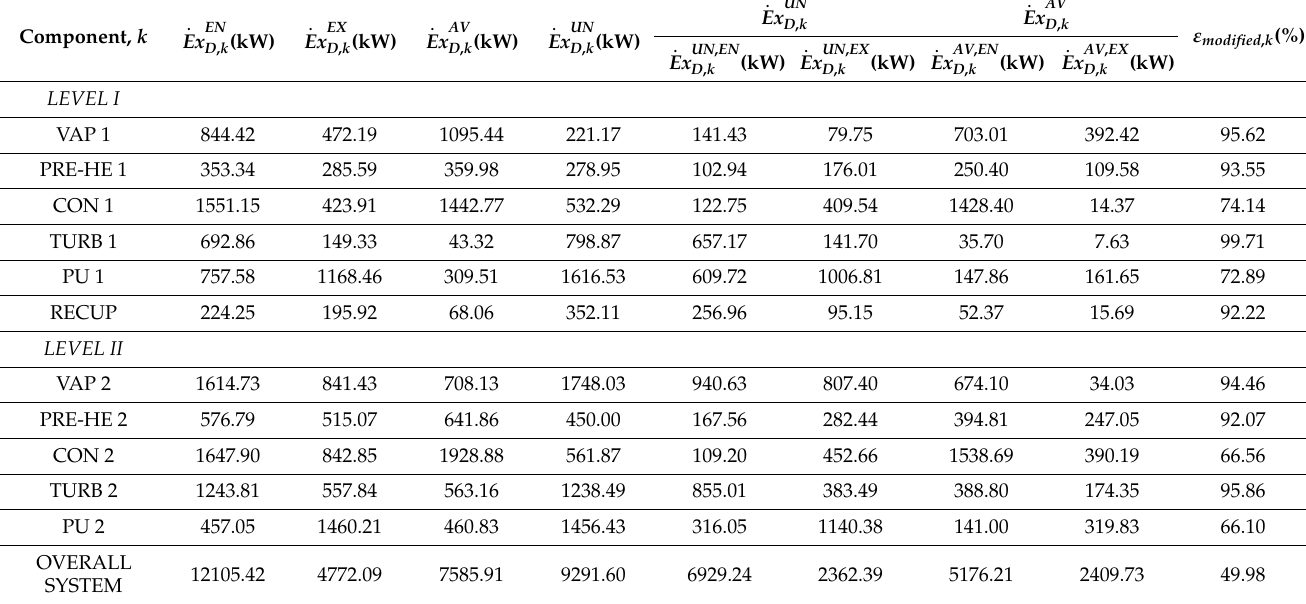
Table 5. The AdvEx analysis findings for all the components of the Sinem